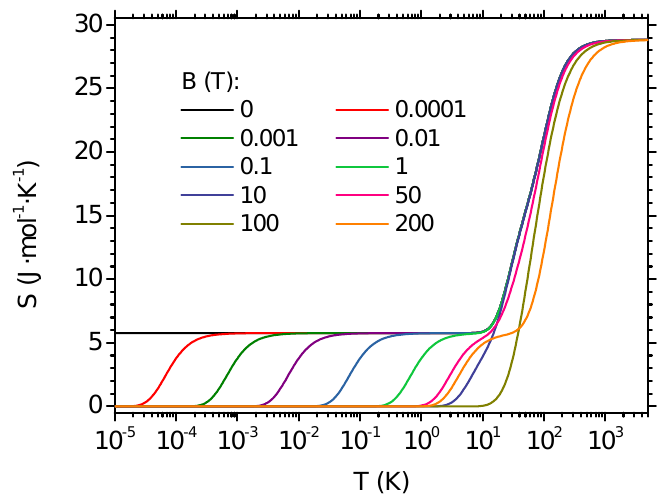
Figure 4. Entropy as a function of the temperature.